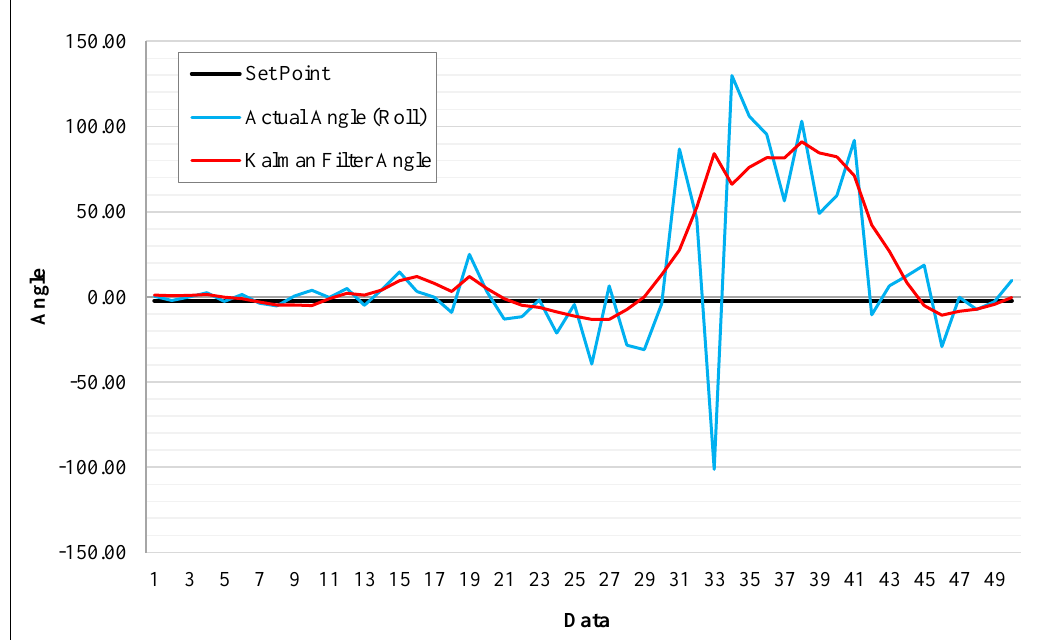
Figure 15. Comparison of angle reading values without